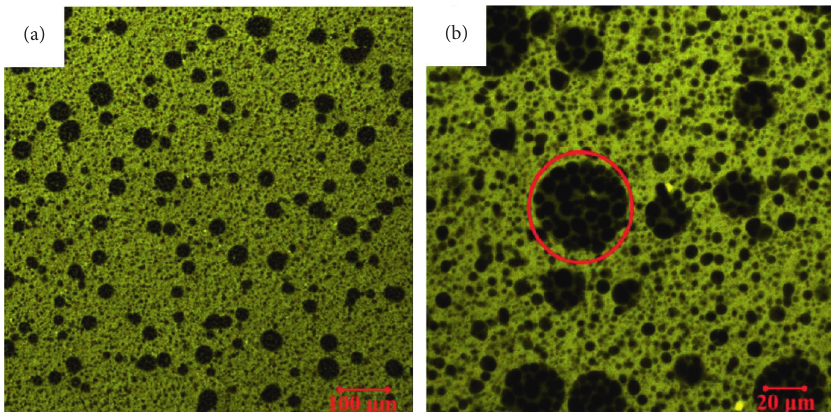
Figure 8: LSCM images of cured ESA: (a) × 100 and (b) × 400